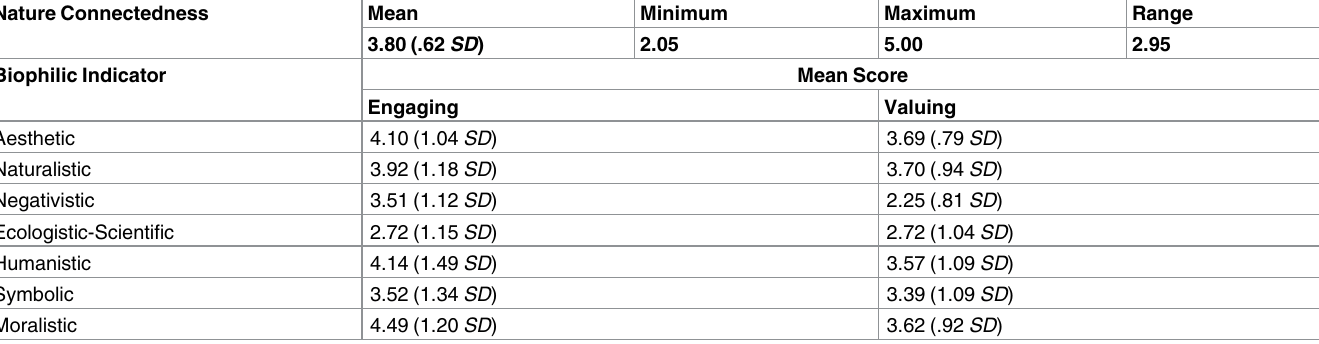
Table 3. The mean engagement scores for the engaging with and valuing indicators (N =